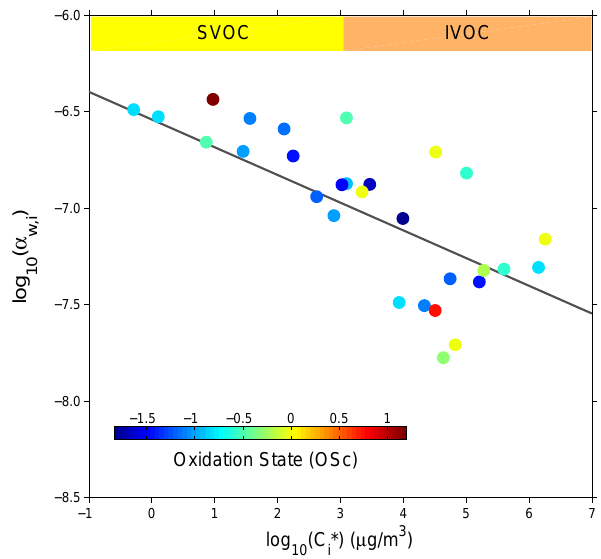
Figure 6. Inferred accommodation coefficients of organic oxidation products on the chamber wall (log 10 (α w ,i )) as a function of satura- )) and average carbon oxidation state tion concentrations (log 10 (C ∗ i (OS C ) . Colored filled circles represent the best-fit α w ,i assuming ir- reversible gas–wall partitioning. The black solid line represents the ) for all linear regression of log 10 (α w ,i ) vs. log 10 (C ∗ i